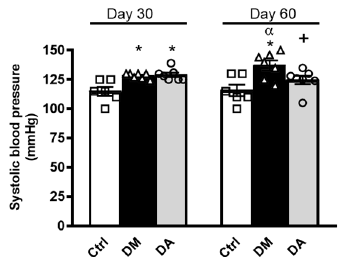
Figure 2. Effects of allicin on systolic blood pressure. Ctrl: control; DM: diabetic; DA: diabetic treated with allicin. mmHg; millimeters of mercury. Values represent mean ± SEM of at least 6 animals from each experimental group. * p < 0.05 vs. Ctrl; + p < 0.05 vs. DM; α p < 0.05 vs. DM day 30. In the renal cortex the protein expression of nephrin, and KIM-1 were used as biomarkers of progression of DN. The data highlighted a higher expression of nephrin and KIM-1 in kidneys from groups with diabetes when compared with control group (Figure 3a,b), which suggested renal injury at glomerular and tubular levels in animals with diabetes. Although the allicin treatment decreased significantly the expression of nephrin and KIM-1, the renoprotective effect was partial (Figure 3a,b).